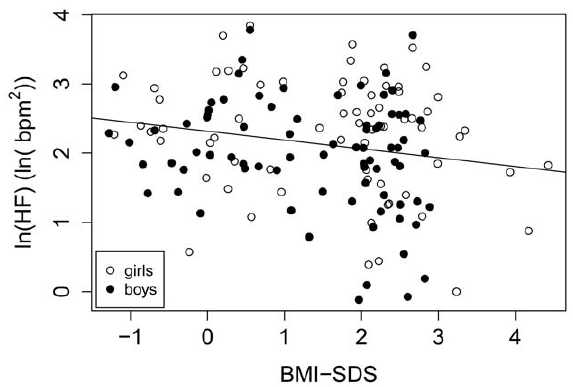
Figure 2. Correlation between ln(HF) (index of parasympathet- ic nervous system) and BMI-SDS in 149 normal-weight and obese children. Pearson’s correlation coefficient= 2 0.19, 95% CI=[ 2 0.34, 2 0.03], (p=0.03).